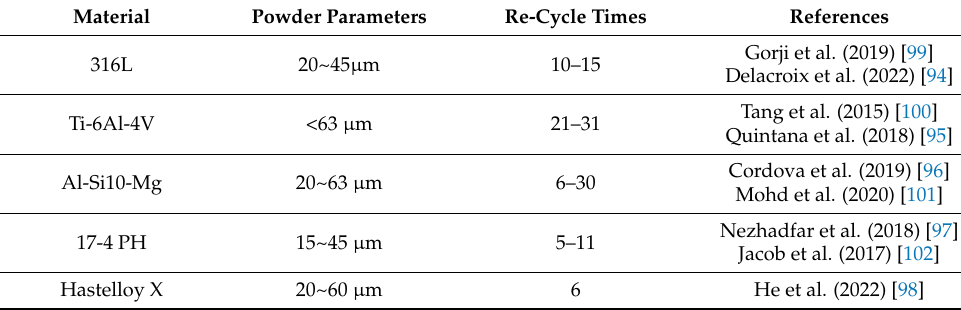
Table 7. Summary of the re-cycle times available for different powders.